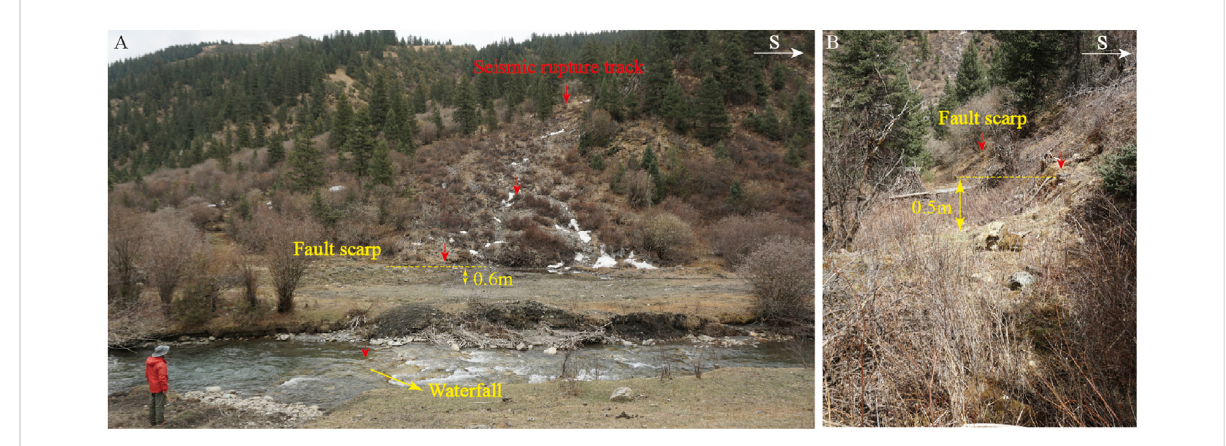
FIGURE 4 Seismic surface rupture zone near the Baiqu River northeast of Babang. (A) Seismic scarp and waterfall developed along the surface rupture zone (E98.80997 ° , N31.67147 ° ), and (B) seismic scarp with a height of 0.5 m (E98.80790 ° , N31.67189 ° ).